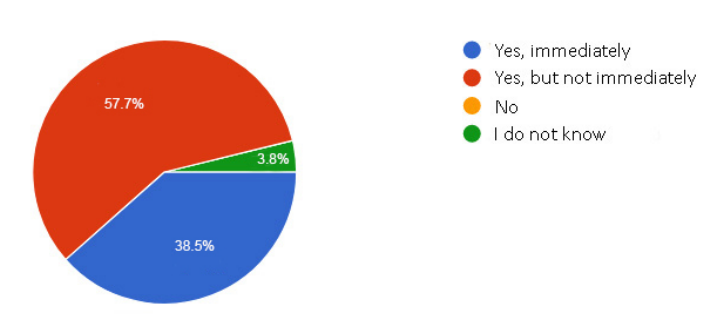
Figure 8. Almost all municipalities are planning to adopt innovative technologies regarding smart waste management systems.